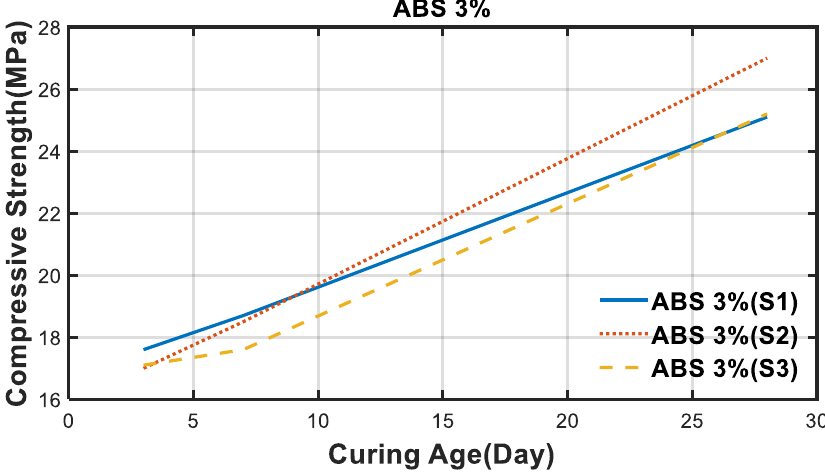
Figure 7. Graph of strength measurement results between ABS (3%) specimens.